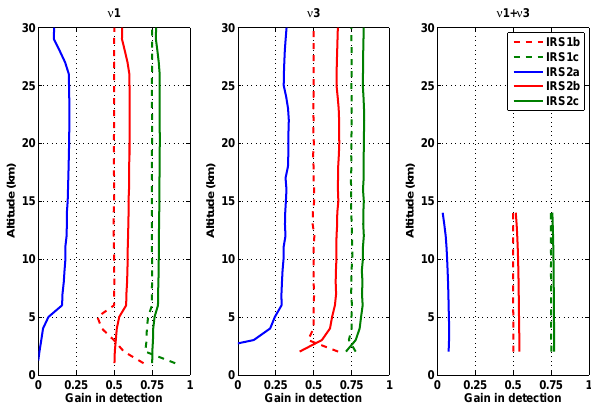
Figure 15. Impact study on the detection limit for SO 2 . The plot represents the relative difference ratio between the detection limit of each scenario and the IRS1a-IASI scenario, as a function of altitude, for a case representative of a tropical atmospheric situation, when using the ν 1 band (left), ν 3 band (middle) and the ν 1 + ν 3 band (right). Note that the sensitivity of the latter band is limited to under